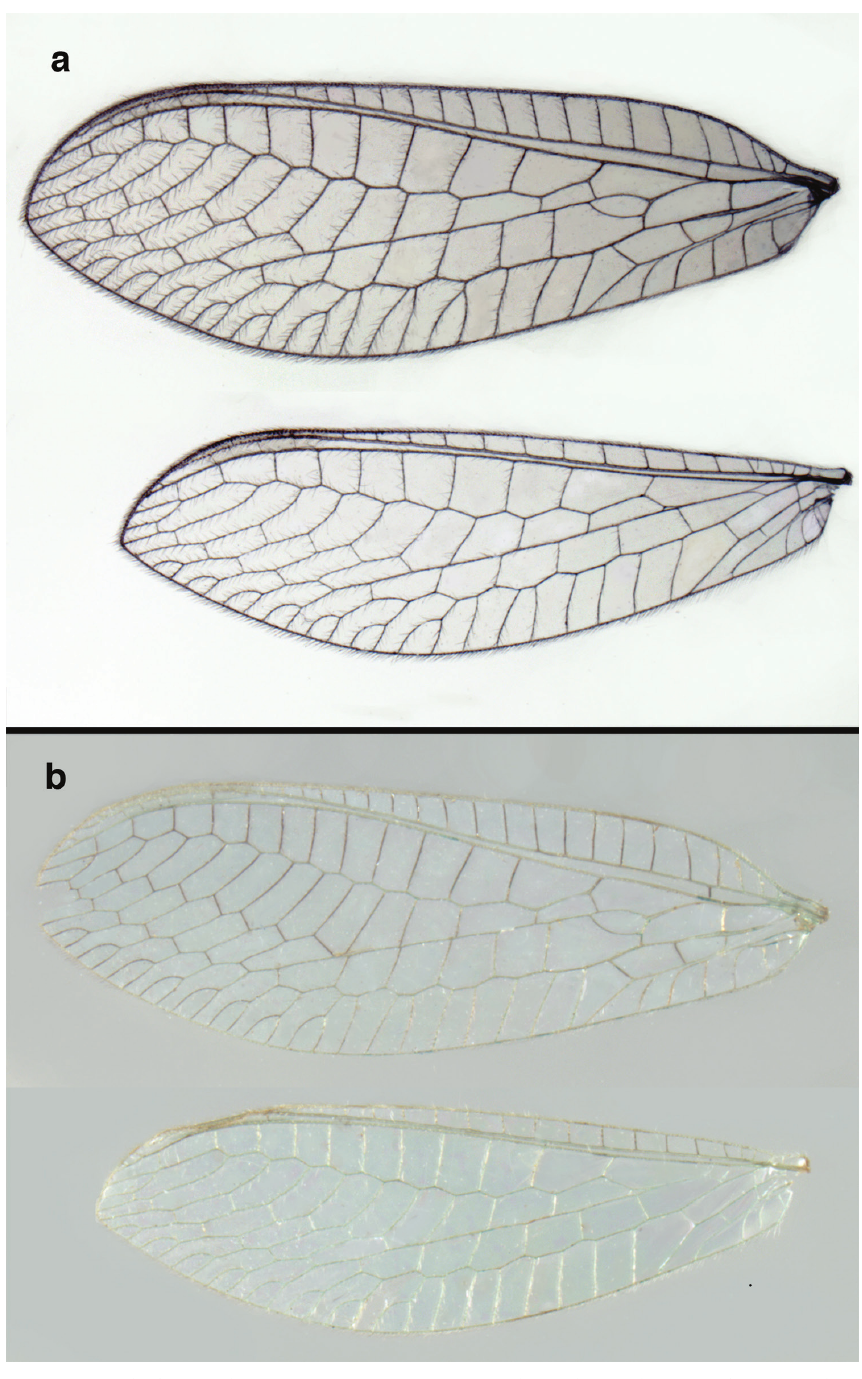
Figure 27. Ungla demarmelsi Sosa: Wings, ( a ) venation emphasized ( b ) coloration of veins emphasized ( a Venezuela, Distrito Capital, male, USNM; b Venezuela, Trujillo, female,